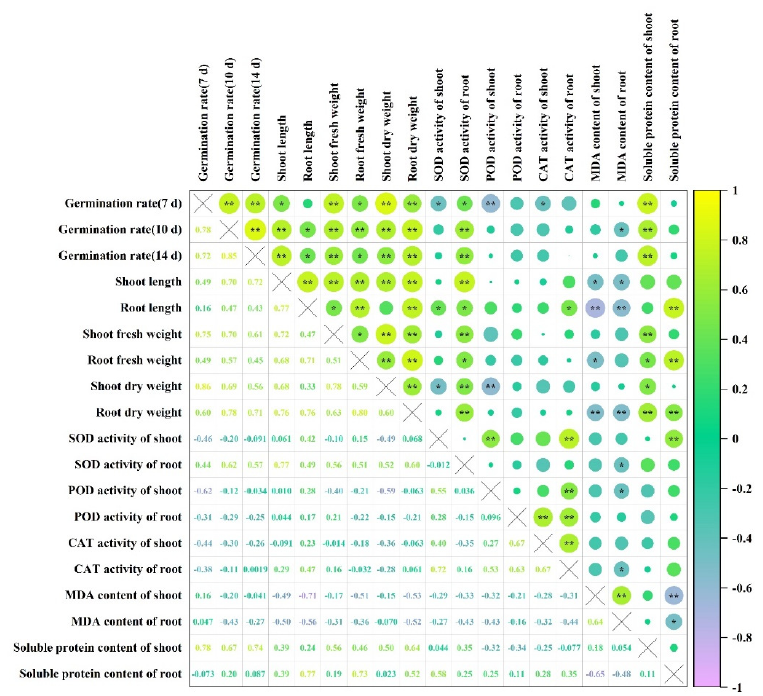
Figure 8. Correlation analysis between seed germination parameters and physiological and biochemical indexes in seedlings. ** Significant at the 0.01 probability level; * Significant at the 0.05 probability level.